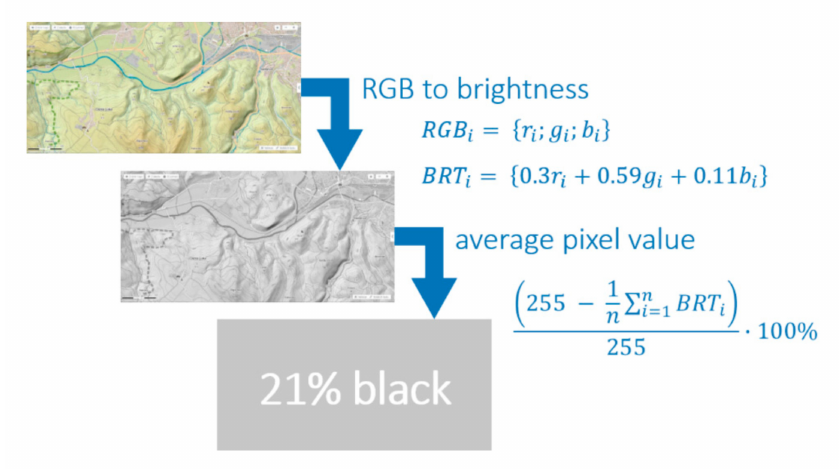
Figure 2. Principle of the average darkness (AD)